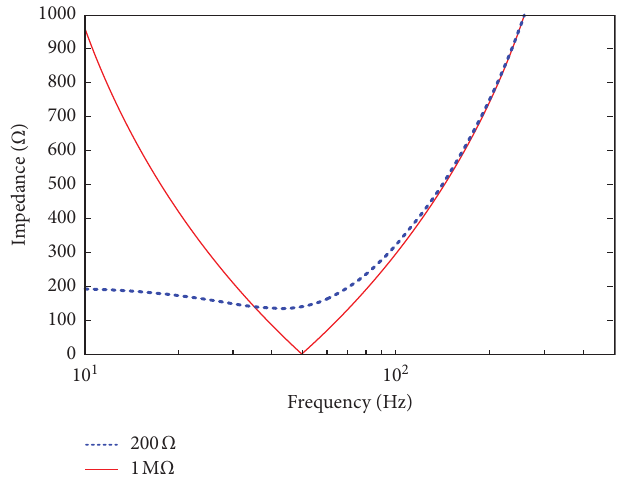
Figure 17: Curve of impedance vs.